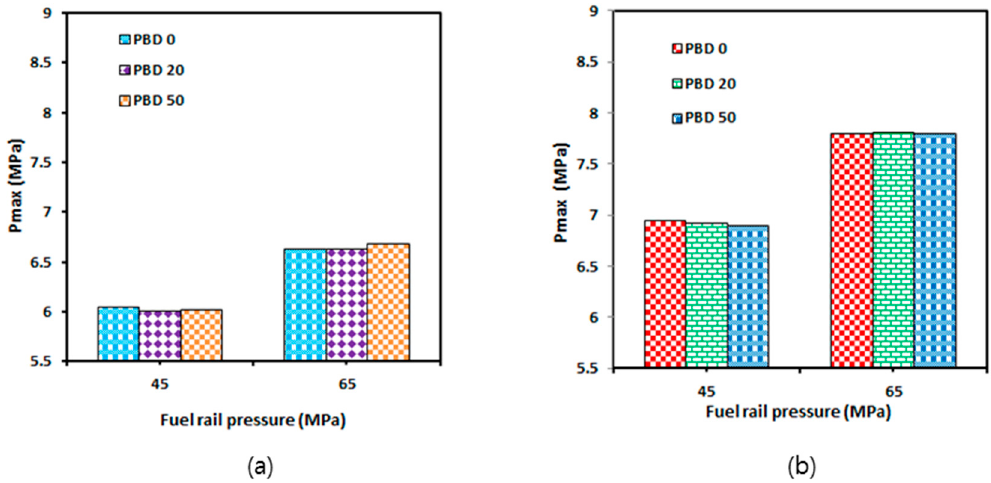
Figure 4. Combustion peak pressure at engine loads of ( a ) 50 Nm and ( b ) 100 Nm. 226